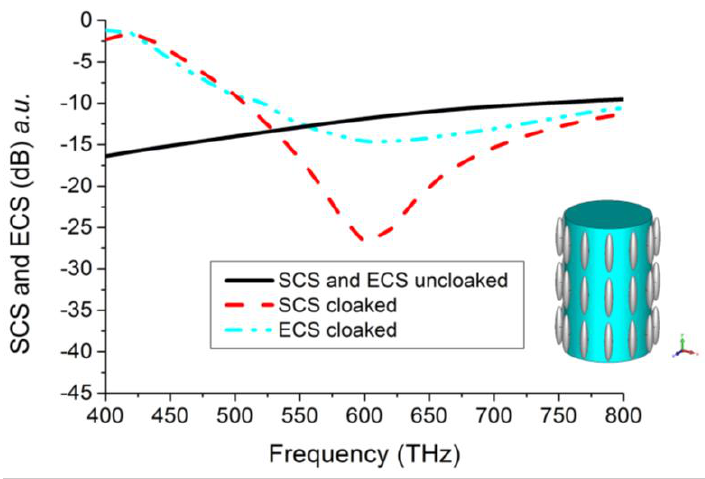
Figure 6. Scattering cross section (SCS) and extinction cross section (ECS) of the first coated cylinder compared to the one of uncloaked cylinder.